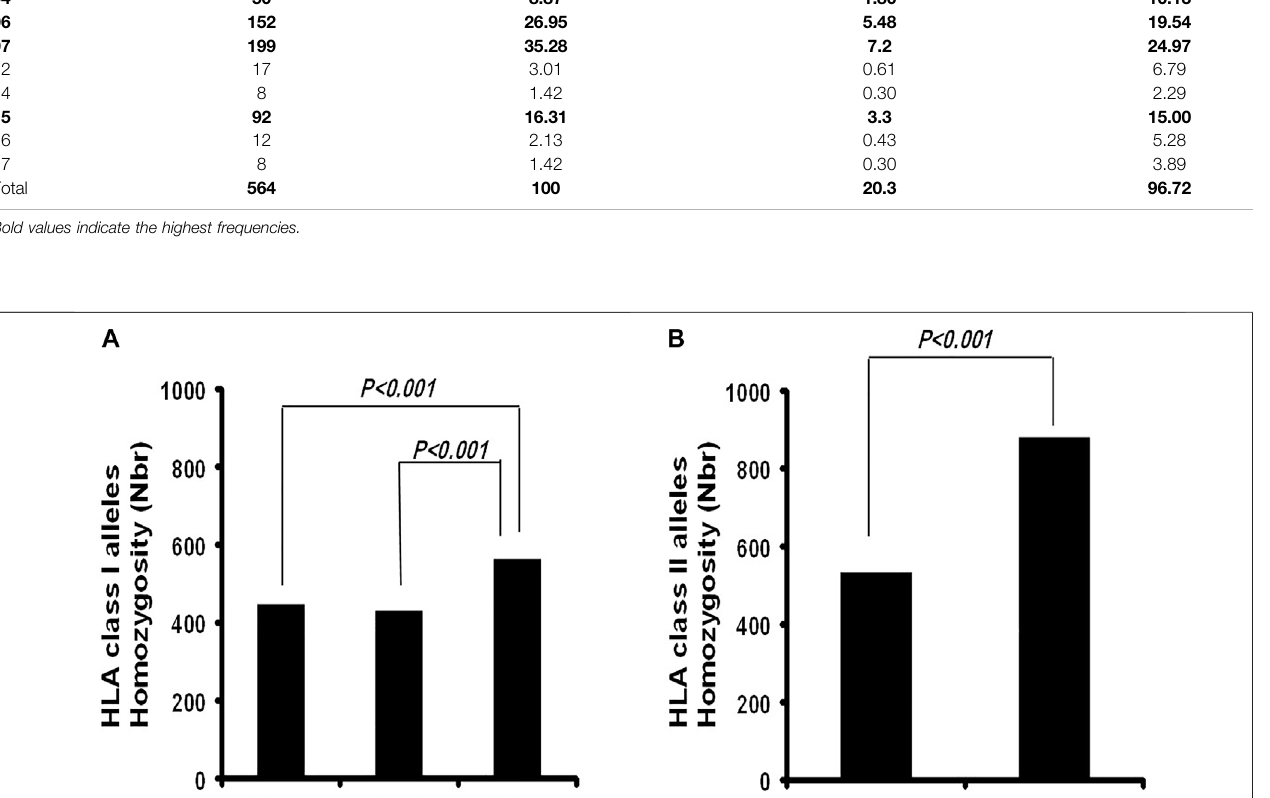
TABLE 4 | List of HLA-DRB1 alleles detected in locus DRB1 and the frequency of homozygosity and allele frequencies. HLA-DRB1 alleles Number of homozygous individuals